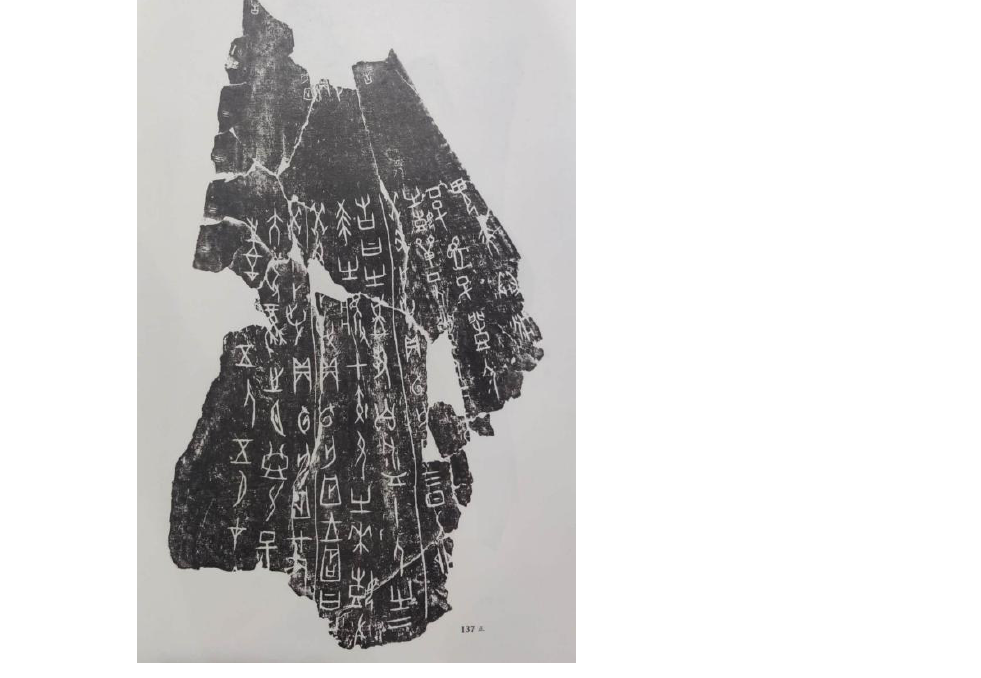
Figure 1. An oracle-bone inscription in which a strong rushing wind in the Shang dynasty is Figure 1. An oracle‑bone inscription in which a strong rushing wind in the Shang dynasty is docu‑ documented (Guo and Hu 1982, p. 32). mented (Guo and Hu 1982, p.